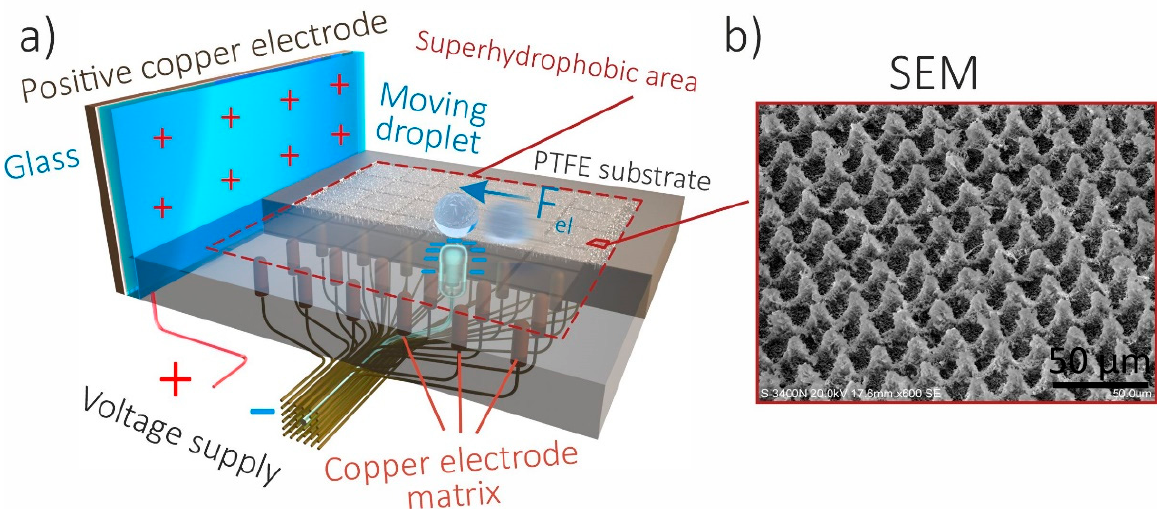
Figure 1. ( a ) schematic of the platform for micromanipulation of liquid droplets and its mechanism of action ( b ) SEM image of the topography of a superhydrophobic surface.